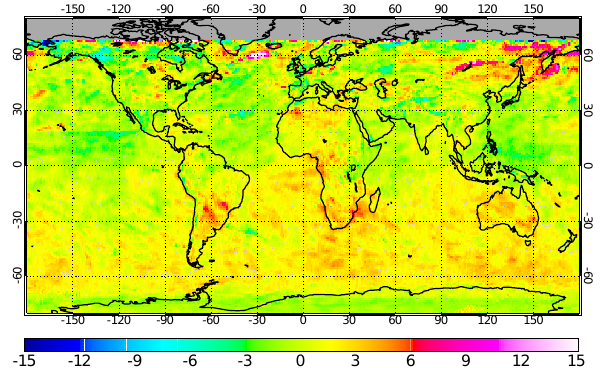
Fig. 7. Example of the global distribution, gridded on 1 × 1 ◦ , of the observation-minus-forecast in DU of the MSR dataset averaged for the month January 2008. The MSR data for this month is based on satellite observations from GOME, SCIAMACHY, GOME2 and